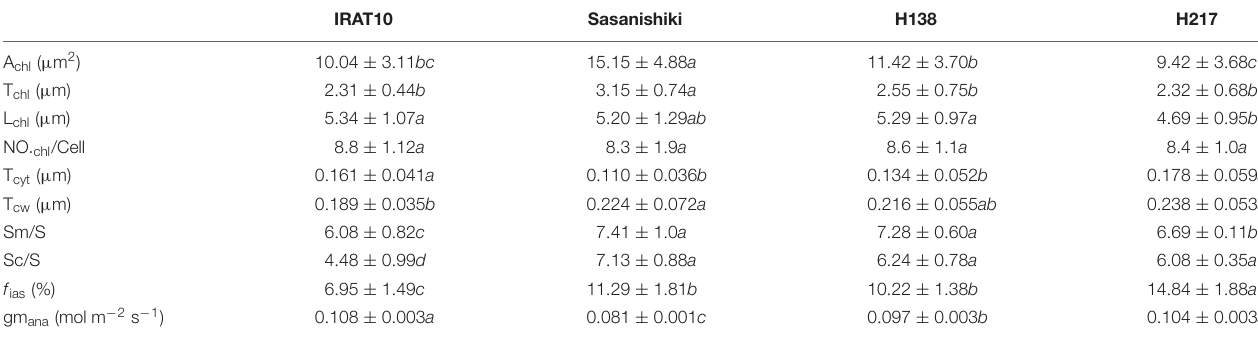
TABLE 2 | The cross-sectional area of chloroplast (A chl , µ m 2 ), the chloroplast thickness (T chl , µ m), the chloroplast length (L chl , µ m), the number of chloroplast per mesophyll cell (NO. chl /Cell), the thickness of the cytoplasm between the cell membrane and the chloroplast (T cyt , µ m), mesophyll cell wall thickness (T cw , µ m), the surface of mesophyll cells and chloroplasts exposed to leaf intercellular air spaces (Sm/S and Sc/S, µ m 2 µ m − 2 ), the volume fraction of intercellular air space ( f ias , %), and gm modeled from anatomical traits (g m ana , mol m − 2 s − 1 ) in the flag leaves of tested